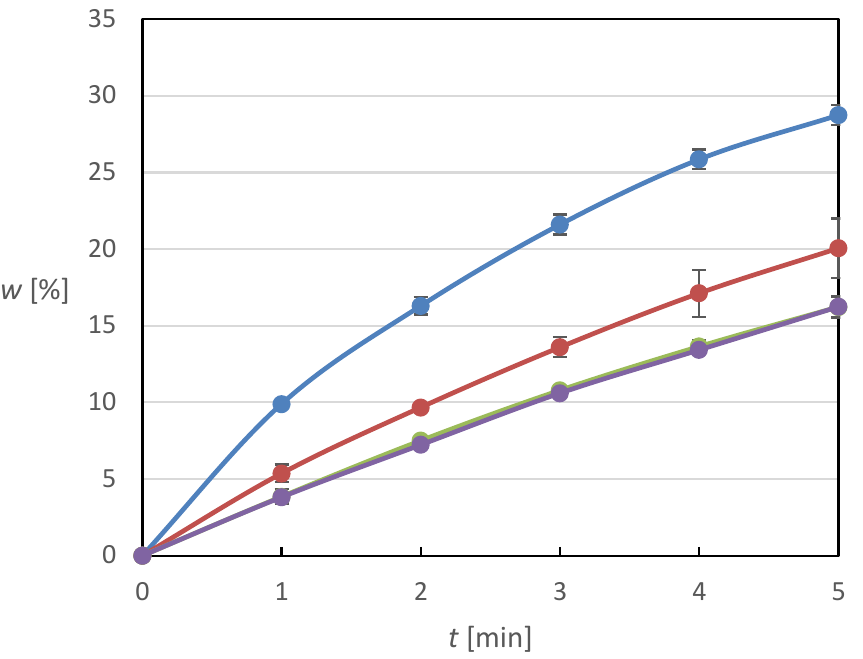
Figure 1. Dissolution profiles of tablets prepared by applying a 2 mg/mL MX THF solution including error bars (5 drops ■ , 10 drops ■ , 15 drops ■ , 20 drops ■ ), error bars are not plotted where the length of the error bar is shorter than the size of the marker (this statement is valid for all subsequent figures); the curves are the connecting points of each data series.